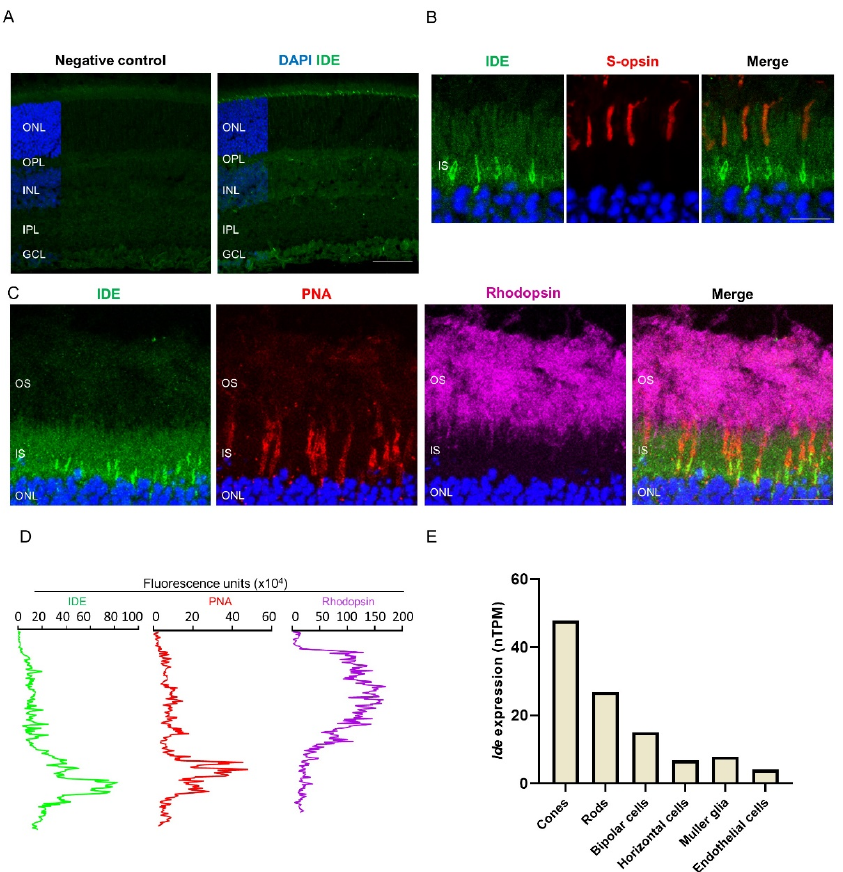
Figure 2. IDE distribution in the wild-type retina. ( A ) Retinal section at P25 immunostained for IDE (green). Nuclei were stained with DAPI (blue). In the negative control, the IDE primary antibody was substituted by normal rabbit serum. ( B ) Magnified image of photoreceptor segments showing double staining for IDE (green) and S-opsin (red). ( C ) Magnified image of photoreceptor segments showing triple staining for IDE (green), PNA (red), and rhodopsin (magenta). ( D ) Diagram shows fluorescence intensity of each fluorophore along the “Y” axis of panels shown in C. OS, outer segment; IS, inner segment; ONL, outer nuclear layer; OPL, outer plexiform layer; INL, inner nuclear layer; IPL, inner plexiform layer; GCL, ganglion cell layer. Scale bars: 60 μ m ( A ), 9 μ m ( B ), and 13 μ m ( D ). ( E ) Ide expression in human individual retinal cell types. Data obtained by single-cell RNA sequencing and extracted from the Human Proteome Map portal (www.proteinatlas.org (accessed on 4 March 2022)). nTPM, normalized transcripts per million.